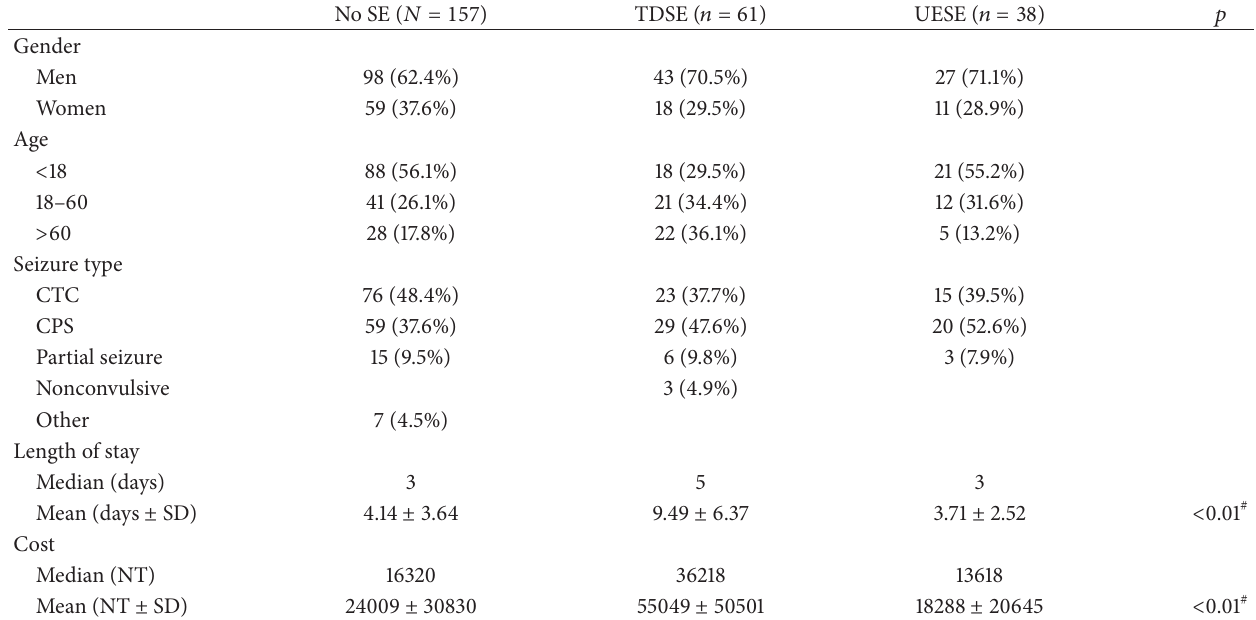
Table 1: Characteristics of seizure ( 𝑁 = 256 ).